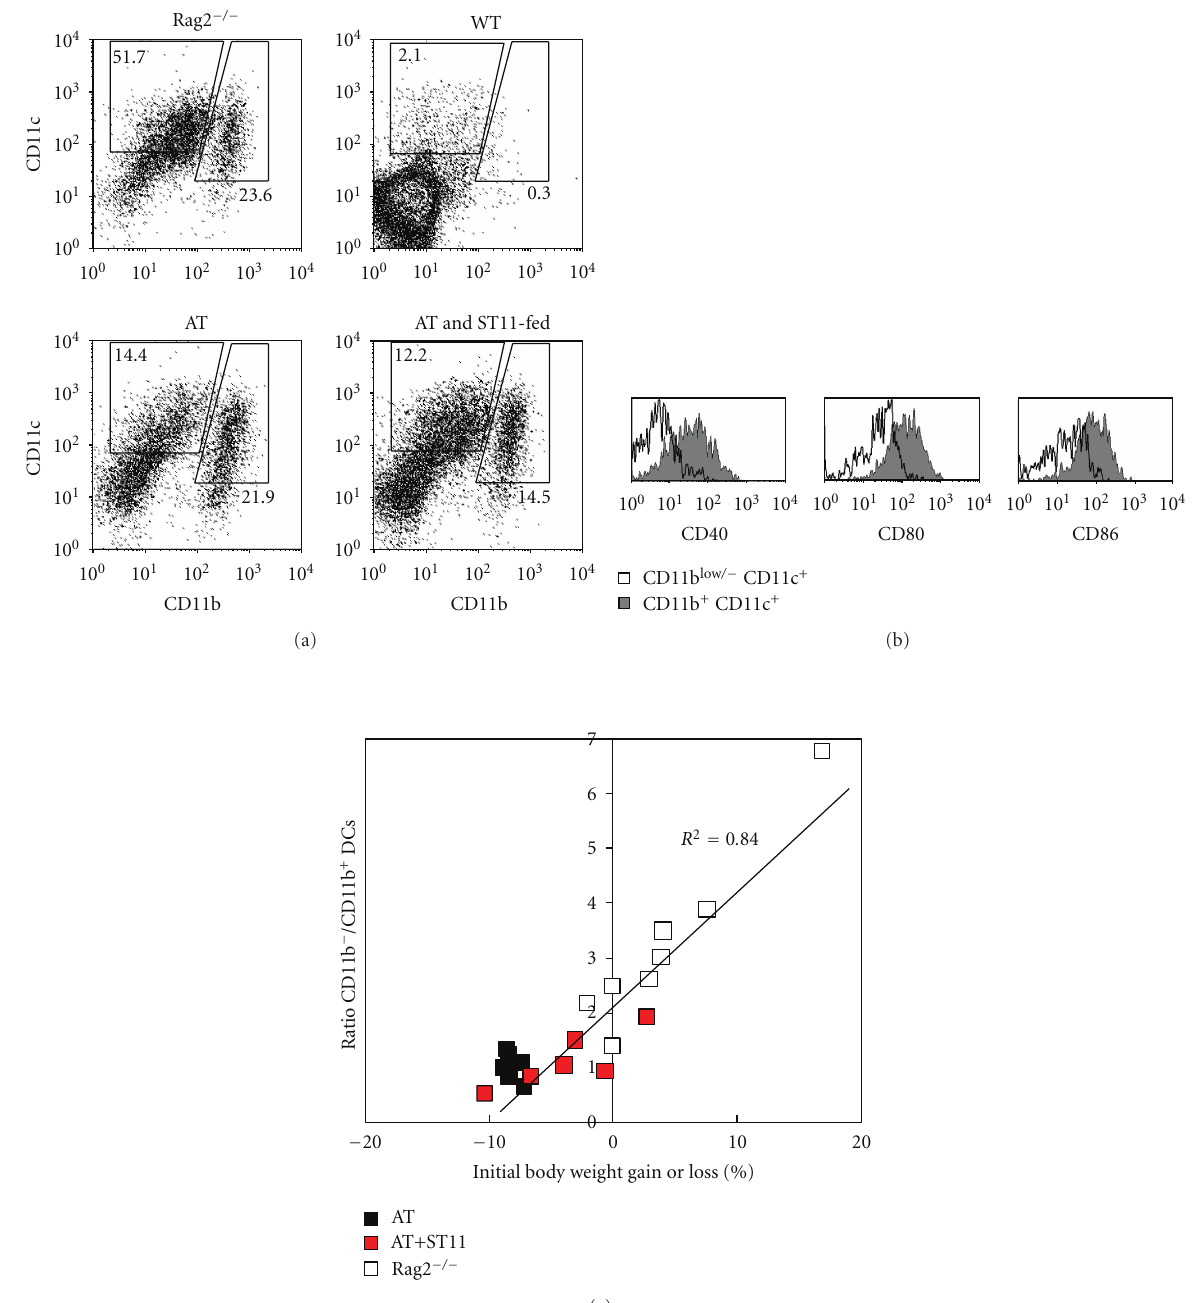
Figure 5: Phenotypic characterization of mesenteric DC after colitis induction. 5 × 10 5 sorted na¨ıve T cells were adoptively transferred into Rag2 − / − mice. (a) After 4 weeks, mesenteric lymph node cell suspensions were made, stained with anti-CD11c and anti-CD11b mAbs, and analyzed by flow cytometry. DC populations were equally important in colitic PBS-fed recipient mice (AT) and ST11-fed mice (AT and ST11-fed). As control, representative stainings obtained with unmanipulated C57BL/6 wild-type (WT) or Rag2 − / − mice (Rag2 − / − ) are shown. Among DCs, two di ff erent subsets were obtained: CD11b − / low CD11c + and CD11b + CD11c + DCs. (b) Representative staining showing CD40, CD80, and CD86 expressions on gated CD11b − / low CD11c + (empty histograms) or CD11b + CD11c + DCs (filled histograms) are shown. (c) Shown is a correlation curve between ratio of CD11b − / low CD11c + and CD11b + CD11c + DCs and body weight change in % loss (negative values) or gain (positive values) in colitic or healthy mice. Each symbol represents an individual mouse. Black-filled, red-filled, or empty squares were colitic PBS-fed mice, colitic ST11-fed mice, or healthy Rag2 − / − mice,